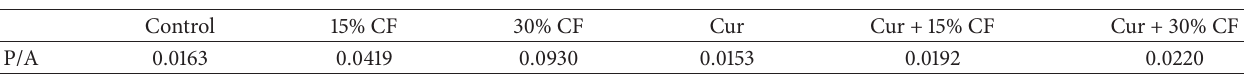
Table 2: Effects of carbofuran and curcumin on the oxidative stress index in the brain stem of rat expressed as the ratio of prooxidant (P)/antioxidants (A).